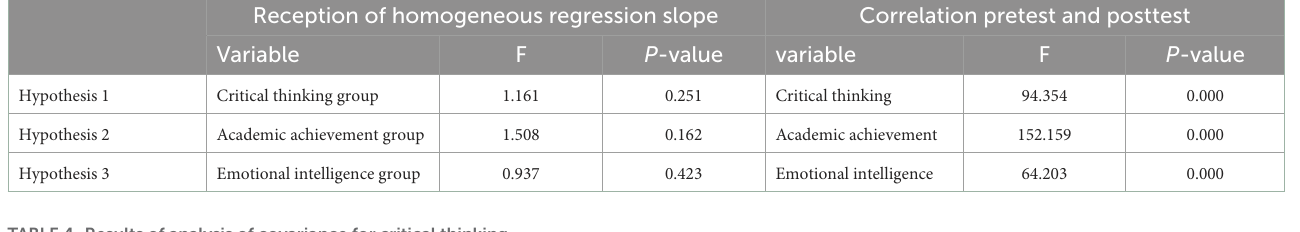
TABLE 4 Results of analysis of covariance for critical thinking.